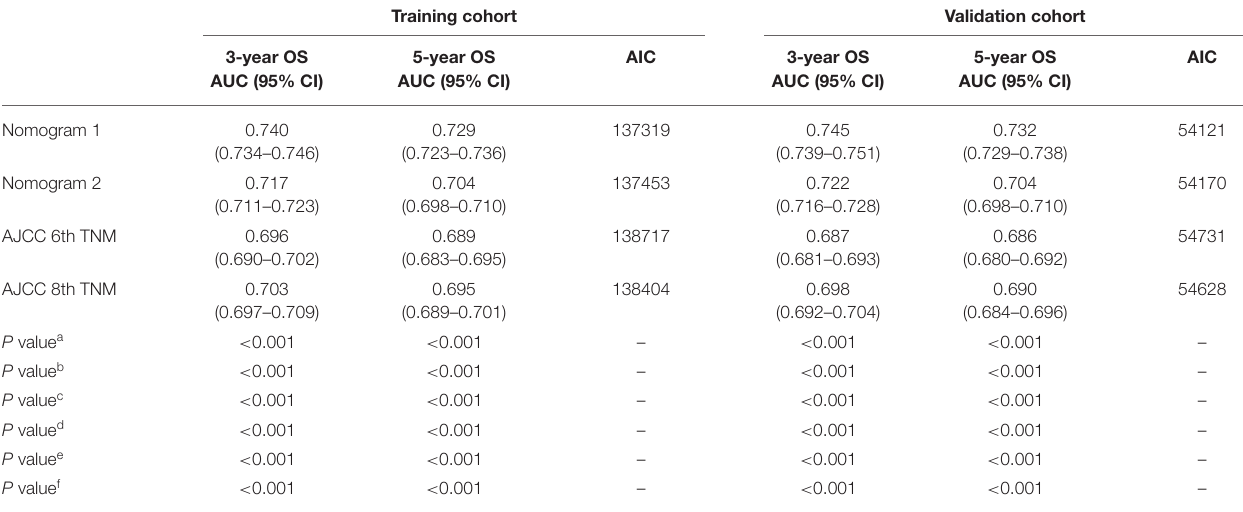
TABLE 4 | Comparisons of different predictive models of nomograms with AJCC 6th and 8th TNM